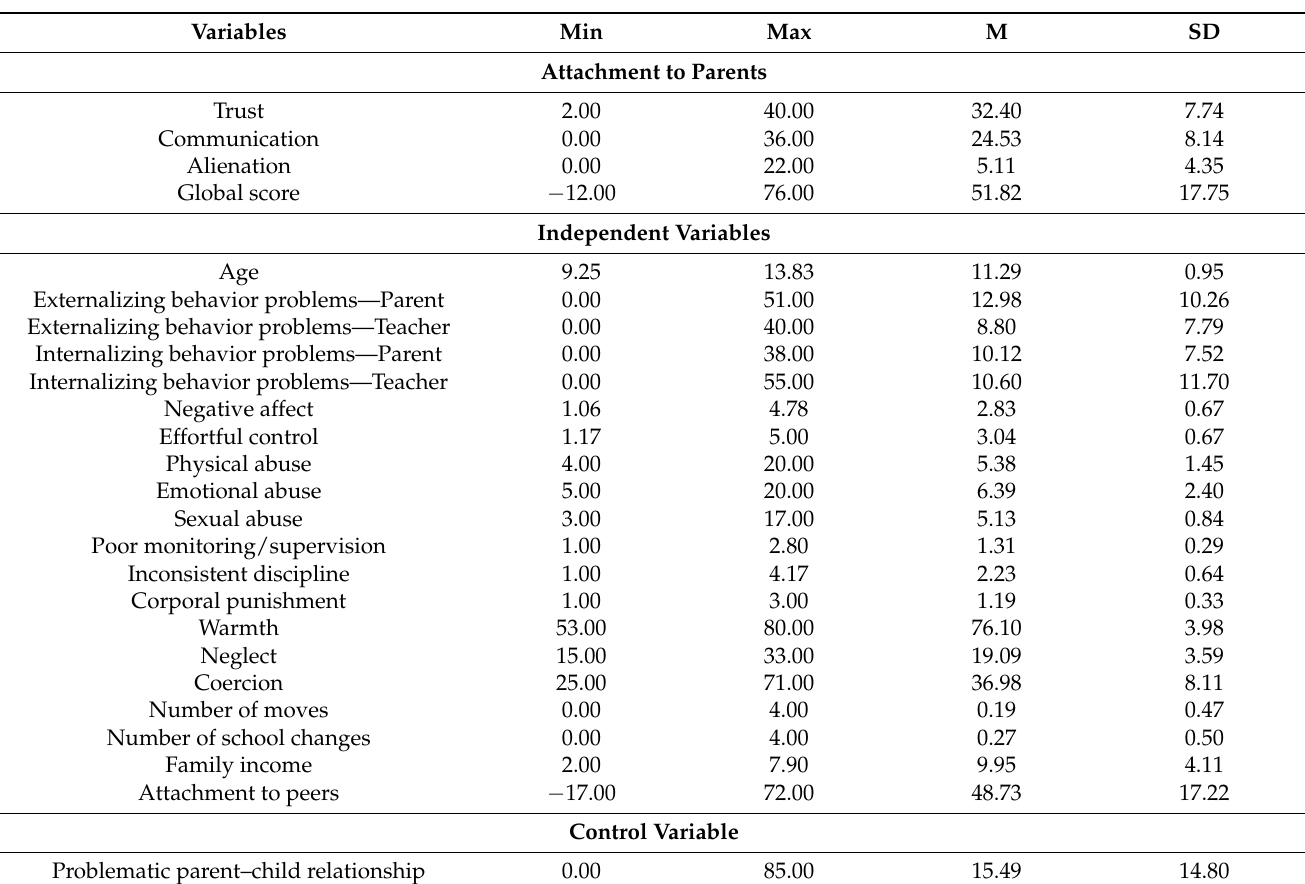
Table 1. Minimums, maximums, means and standard deviations of the study